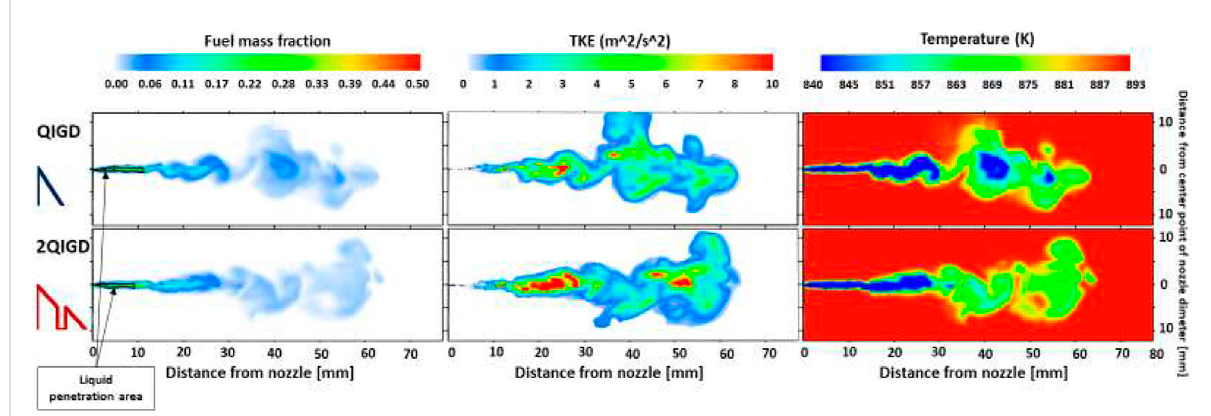
FIGURE 13 Comparisons of distribution of liquid, fuel mass fraction, TKE, and temperature history of QIGD and 2QIGD at 1.3 ms.